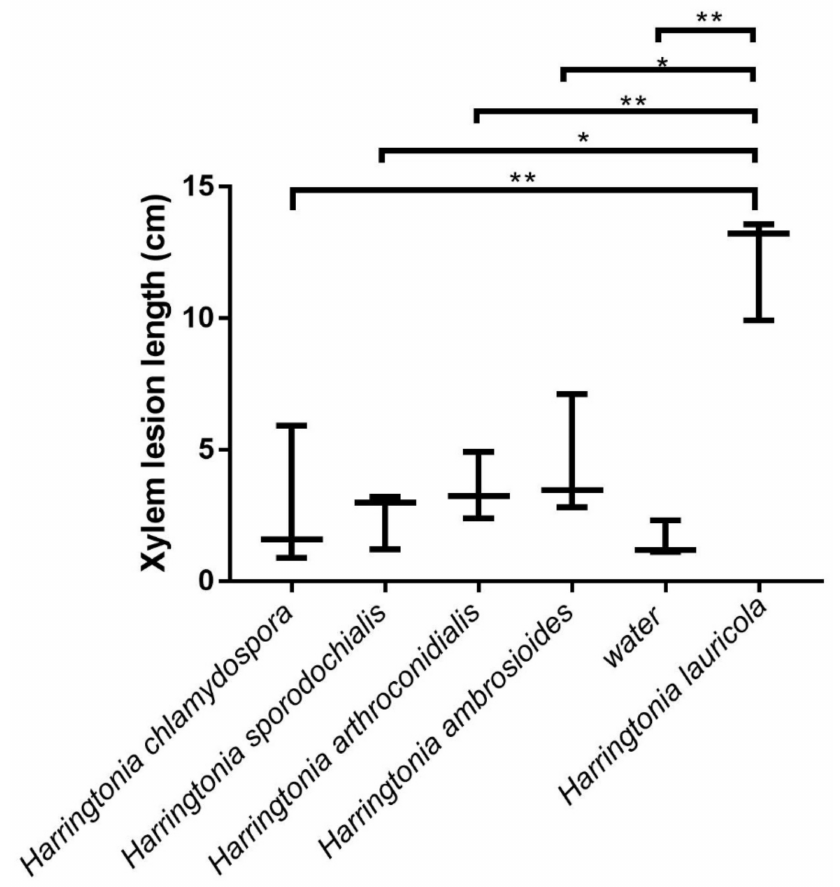
Figure 6. Lesion length response by red bay tree inoculated with different Harringtonia fungi and water. Bar of lesion length with the asterisks in each column indicated significant difference (* p < 0.05; ** p < 0.01) with Tukey HSD